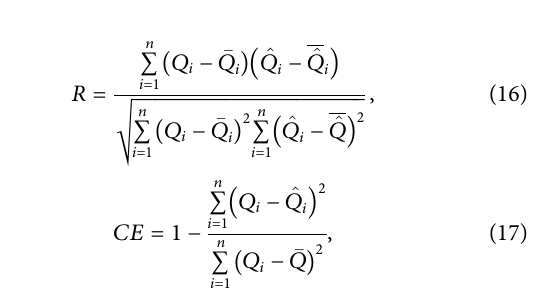
Frontiers in Environmental Science |